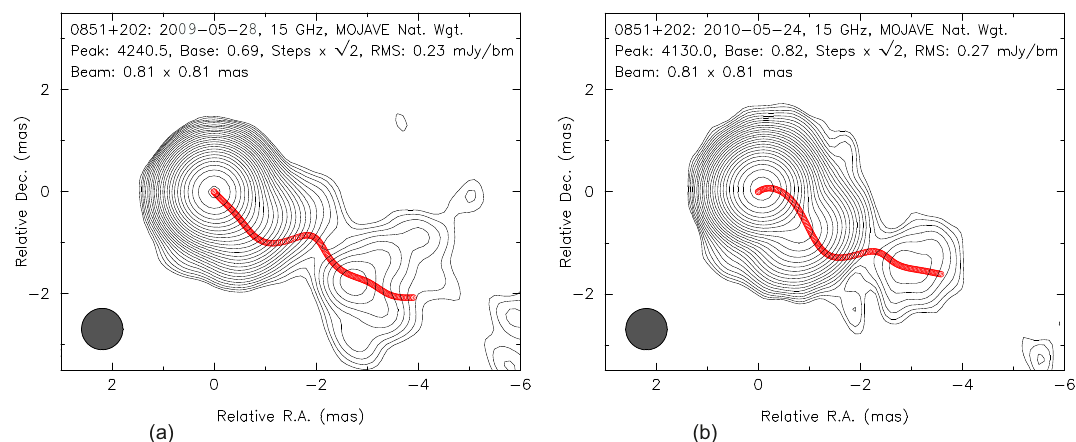
Figure 2. Contour images of the source with ridgeline overlaid at two epochs, before ( a ) and after ( b ) the abrupt change in the inner jet position angle.